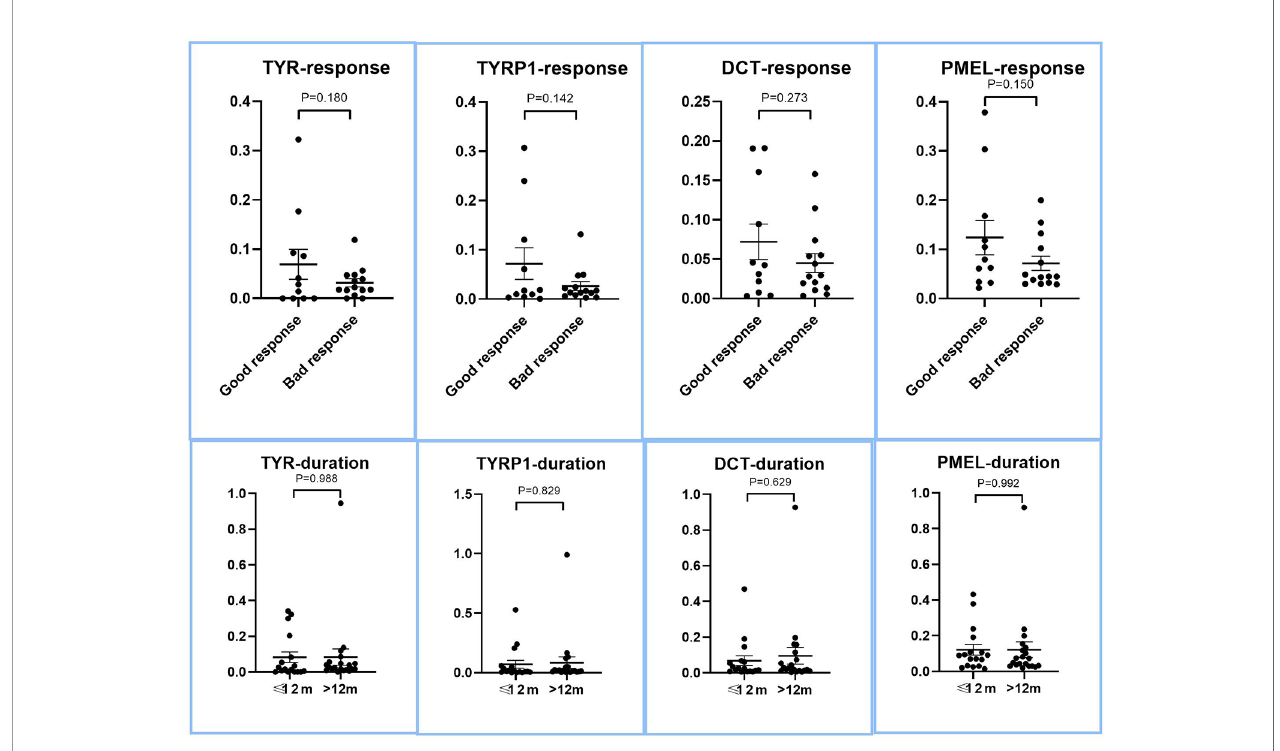
FIGURE 2 | Expression of melanocyte marker genes in lesions with good and bad response to therapy, and between long and short duration lesions. The LS/NLS expression ratios of major melanocyte marker genes, DCT, TYR, TYRP1, and PMEL of good and bad response groups are presented as dot plots. There was no signi fi cant relationship between the expression levels of these genes and therapeutic response (p >